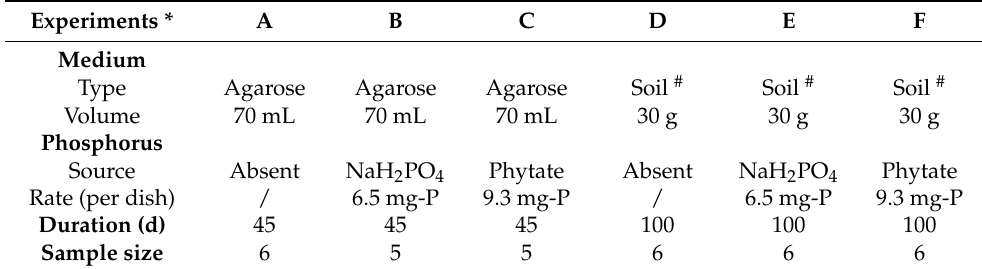
Table 1. Protocols used in the four microcosm